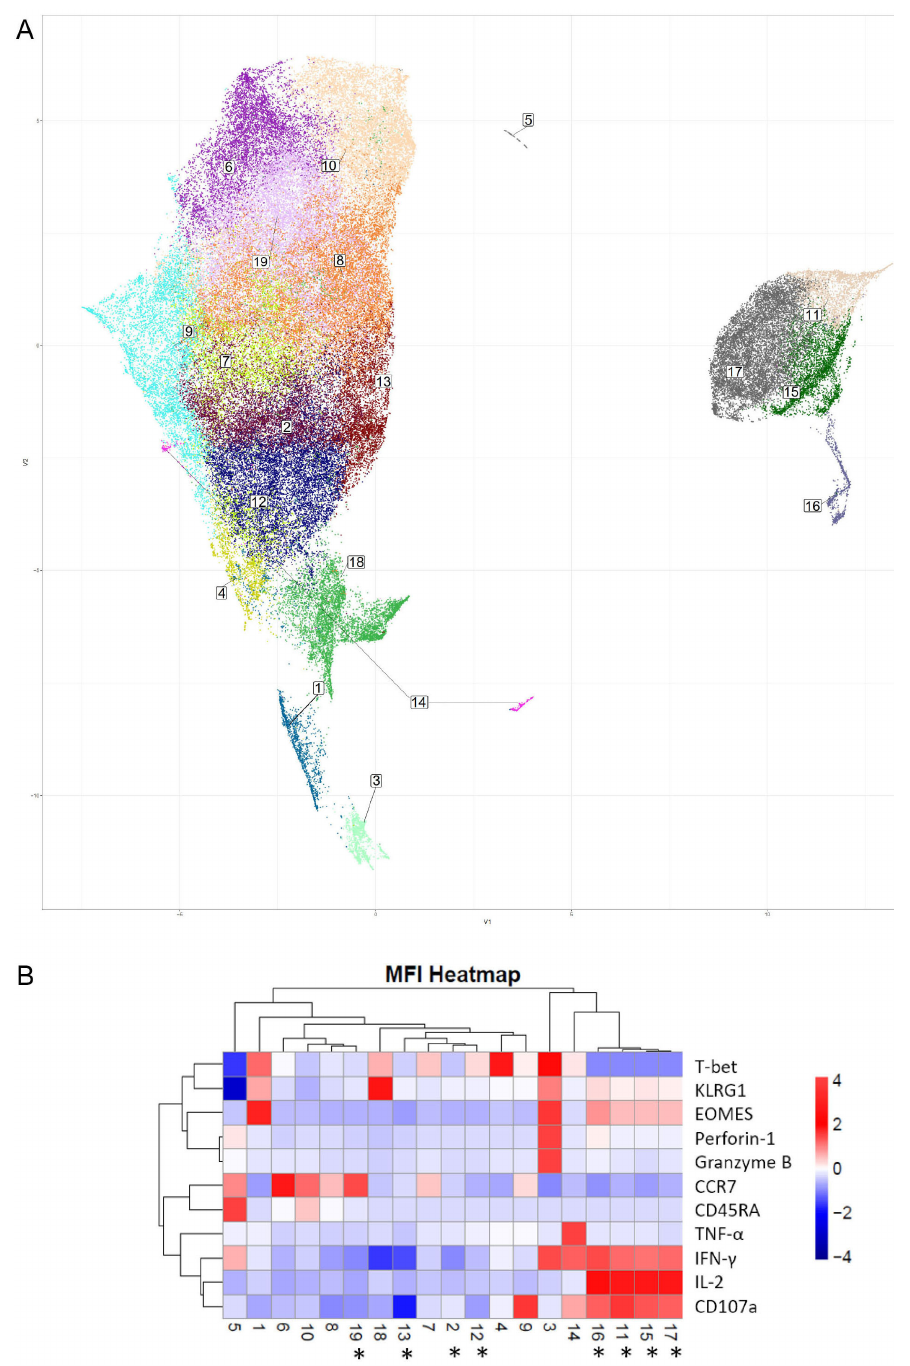
Figure 5. Dimension reduction (Uniform Manifold Approximation and Projection or UMAP) analysis of phenotypic flow cytometric data from acute and prior group samples . (A) UMAP analysis of total CD4+ T-cell response upon VZV stimulation with cluster numbers indicated, (B) heatmap showing the normalized expression levels of T-cell markers and effector molecules for each indicated cluster based on MFI. Asterisks denote statistically significant differences in cluster frequencies between the acute and prior groups (*: P